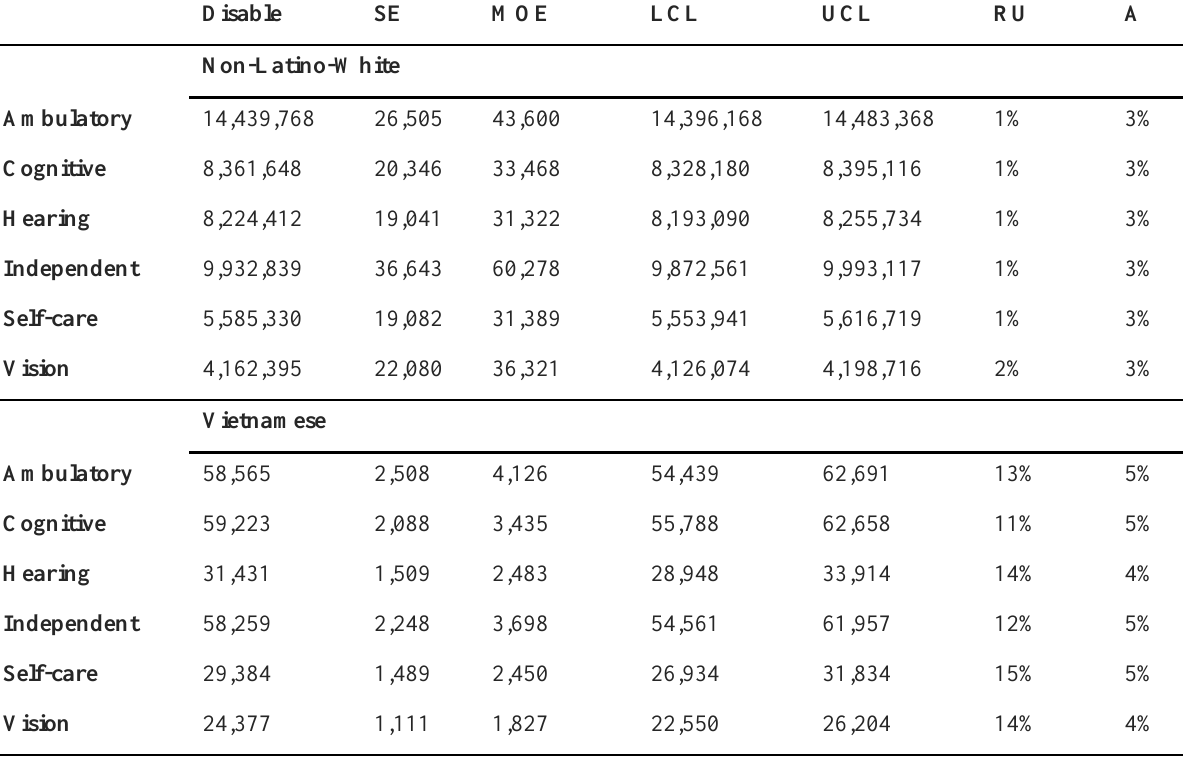
Table 1: Weighted number of Non-Latino-White and Vietnamese with disabilities and corresponding estimate precision